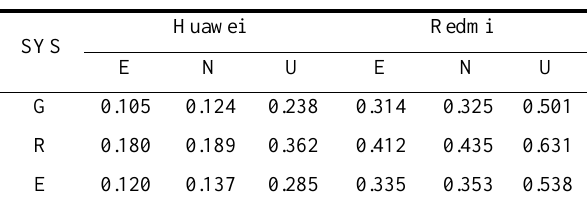
Table 4. RMS of single-constellation velocity determination error. (Unit: m/s)